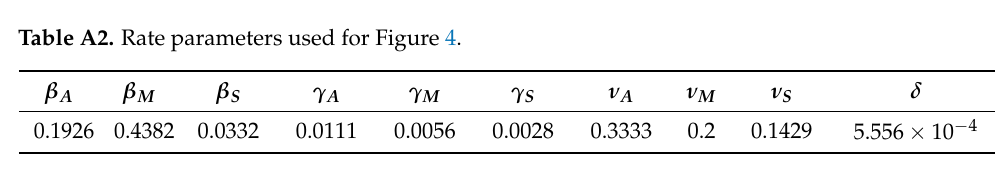
Table A3. Rate parameters used for Figures 6 and 7.